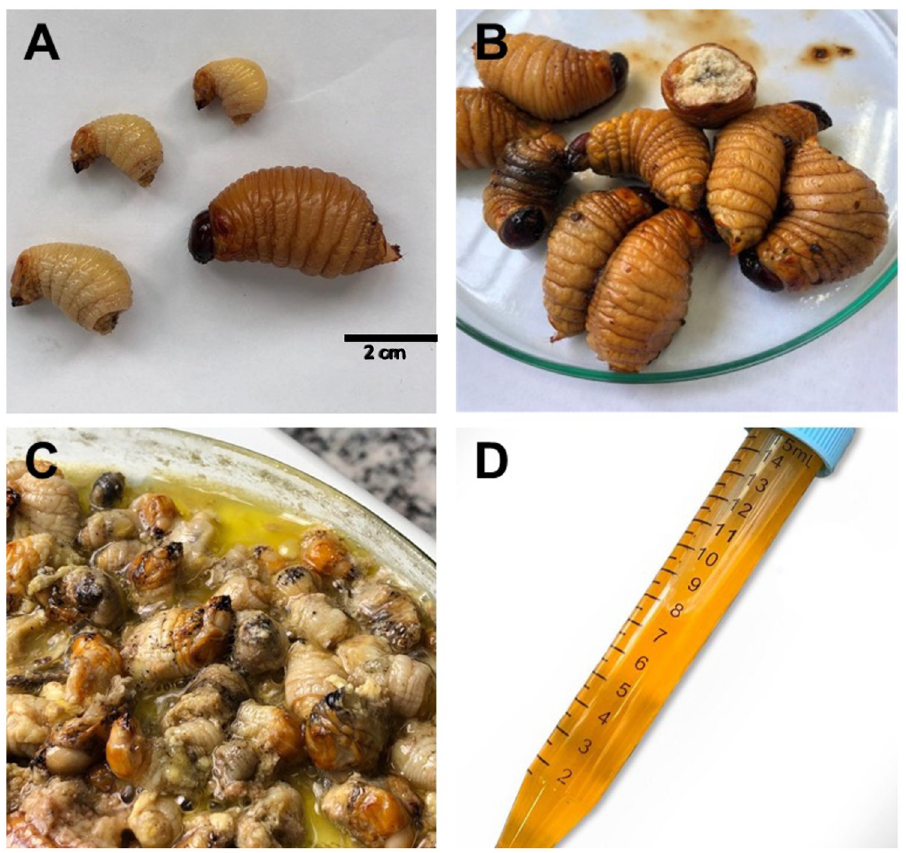
Fig 2. Process of obtaining oil from R . palmarum larvae. (A) Larvae of different sizes; (B) thawing of the larvae; (C) heating process, where it is possible to observe the release of oil next to the larvae integument and (D) oil collected at the end of the heating